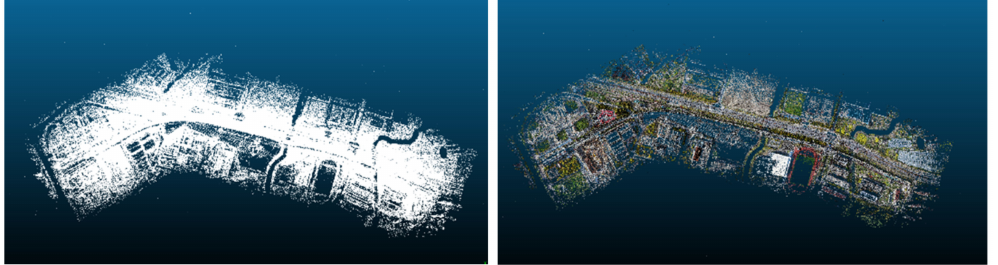
Figure 9. Overall effect of sparse point clouds of magnetic levitation track: ( a ) The color of points are empty; ( b ) The color of points with